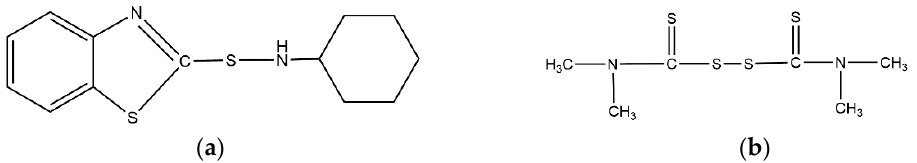
Figure 5. Chemical compositions of the accelerators n-cyclohexyl-2-benzothiazolesulfenamide CZ ( a ) and tetramethylthiuram disulfide TMTD ( b ).